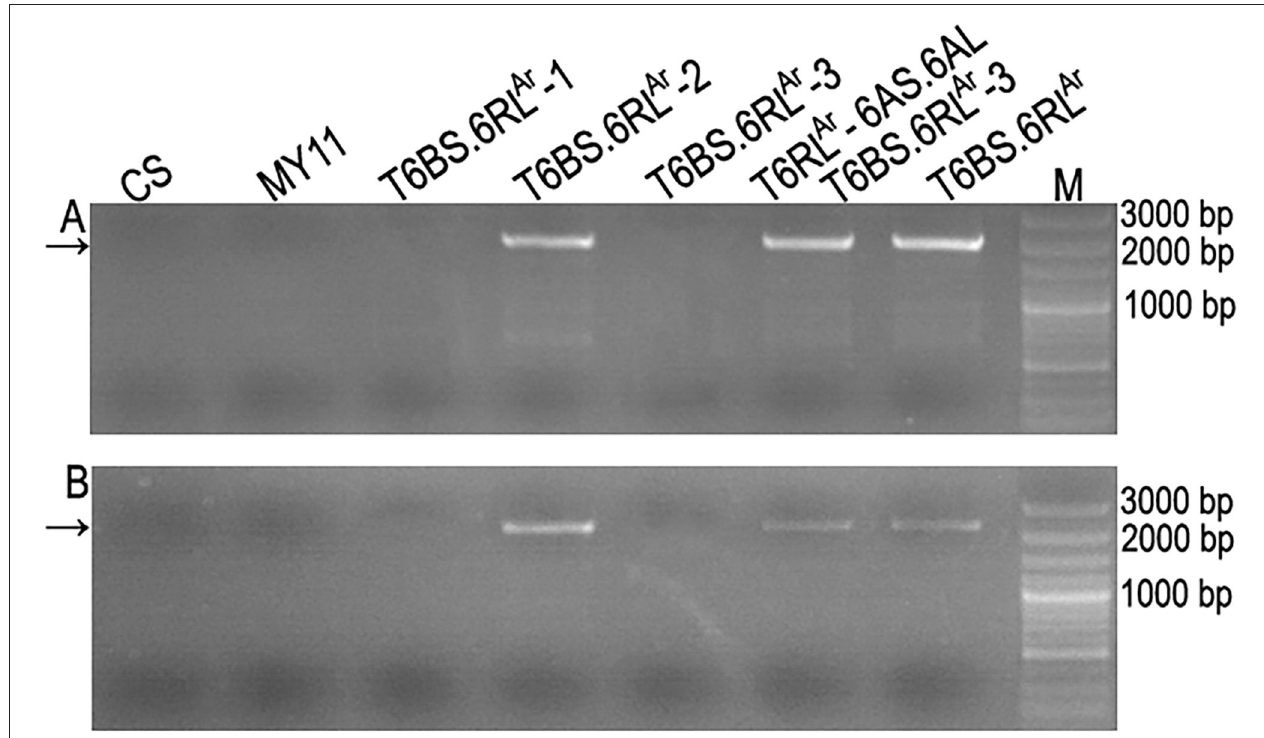
FIGURE 6 | Amplification of partial segments of genes SECCE6Rv1G0449960.1 and SECCE6Rv1G0453070.1 . (A) Products amplified by primer pair P60. (B) Products amplified by primer pair P70. Arrows indicate the target bands amplified by the two primer pairs. Common wheat Chinese Spring (CS) and Mianyang11 (MY11) were used as controls. M: DNA